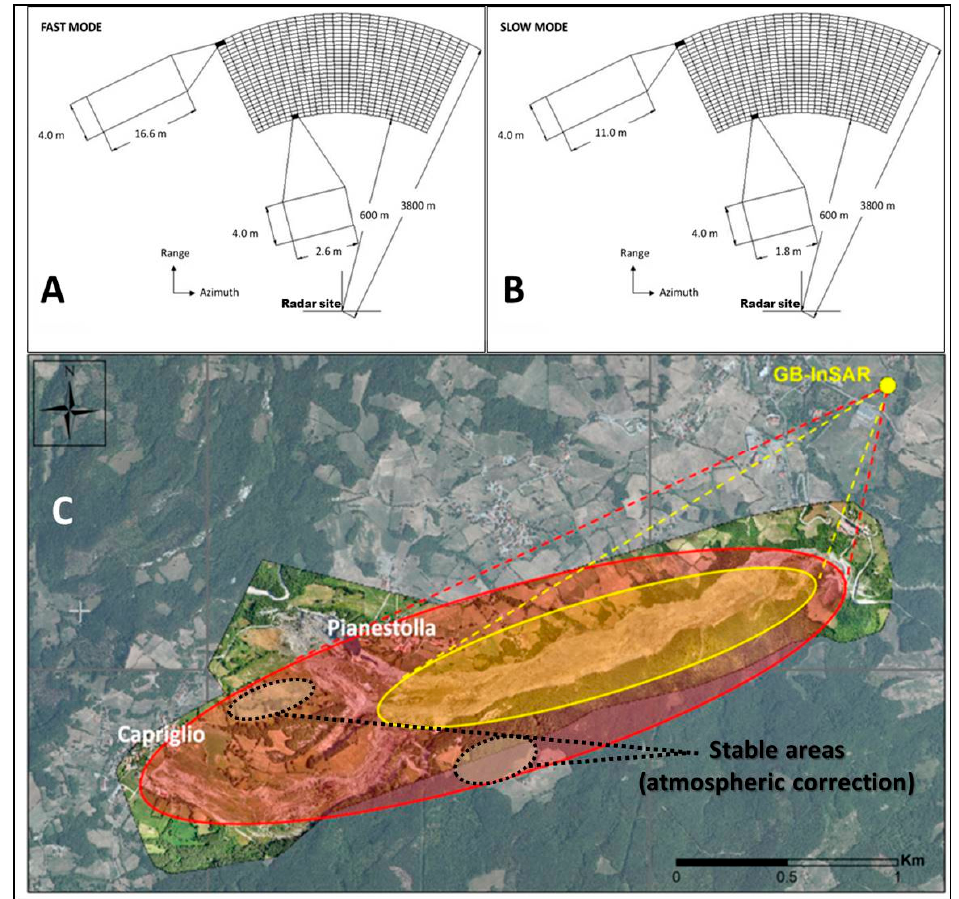
Figure 6. Resolution grid size and parameters in fast acquisition mode ( A ) and in slow acquisition mode ( B ); detected area using fast (in yellow) and slow (in red) acquisition modes ( C ). Black dashed ovals represent stable areas selected to apply atmospheric correction.